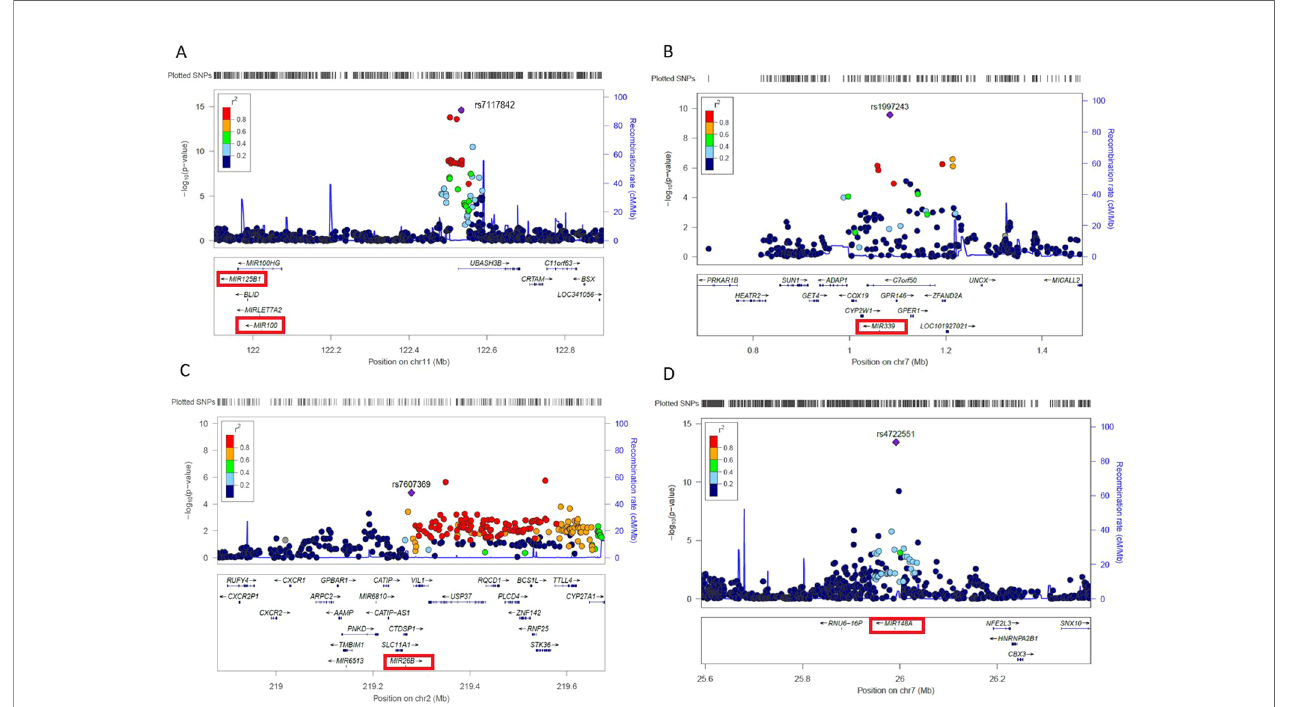
FIGURE 3 | Regional plots showing the association offour top miRNA-SNPs with cardiometabolic traits. The most signi fi cant SNP in the region, according to P-value, is represented by a purple diamond, and the degree of linkage disequilibrium of other SNPs in the region to the lead SNP is representative by the color scale shown in the legend. Genes are illustrated below. The associated miRNA is illustrated with a red box. (A) Regional plot showing the association of rs7117842 located ~512kb upstream of miR-100- 5p/125b-5p with TC, LDL and HDL on the Chr11q24.1 locus. (B) Regional plot showing the association of rs1997243 located ~21kb upstream of the primary transcript of miR- 339-3p with TC and HDL on the Chr7p22.3 locus. (C) Regional plot showing the association of rs7607369 located ~11.7kb upstream of the primary transcript of miR-26b-5p with BMI and TG on the Chr2q35 locus. (D) Regional plot showing the association of rs472551 located ~2kb upstream of the primary transcript of miR-148a with LDL, TG, and TC on the Chr7p15.2 locus.